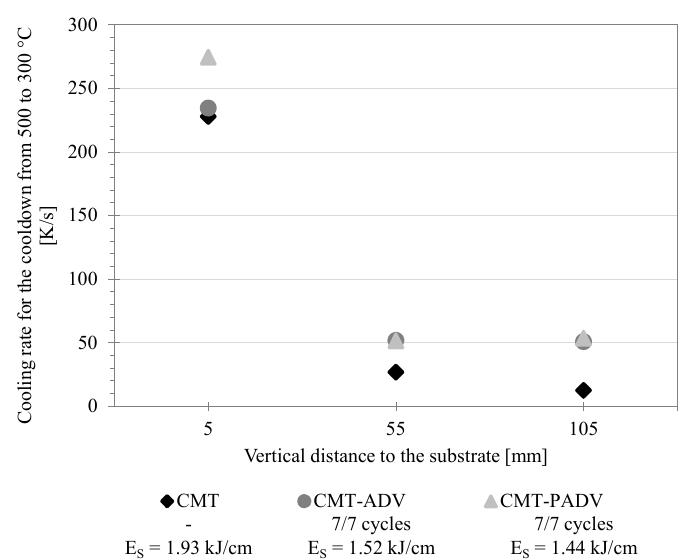
Figure 13. Representation of the cooling rate for cooling from 500 to 300 °C as a function of the vertical distance of the measuring point to the substrate plate and of the arc mode.